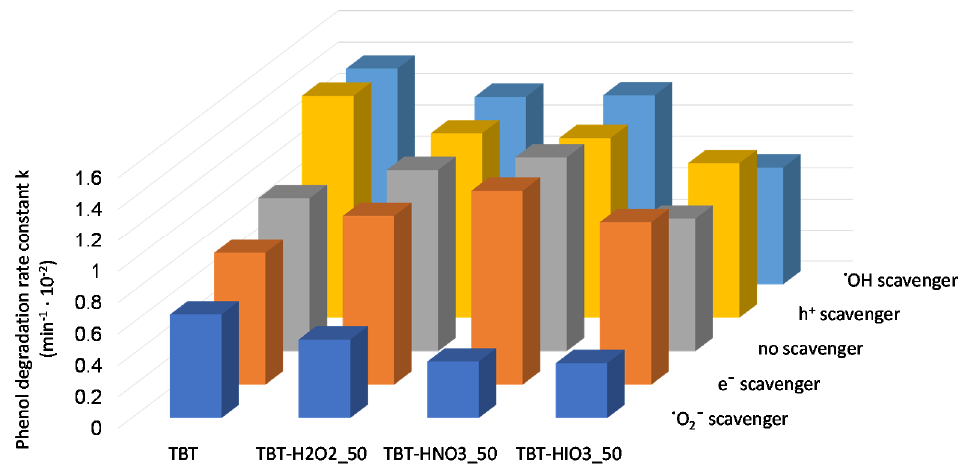
Figure 5. UV-Vis photocatalytic degradation of phenol for defective TiO 2 photocatalysts in the presence of e − , h + , • O 2 − , and • OH scavengers.